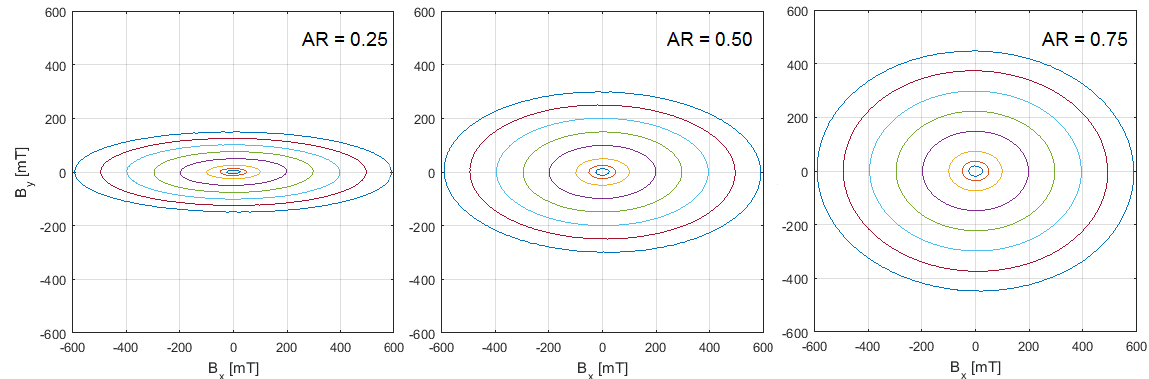
Figure 5. Families of elliptic loops relative to SET 2 measured at different amplitudes for each one of the constant values of the aspect ratio AR = 0.25 (left panel), AR = 0.50 (center panel), and AR = 0.75 (right panel).